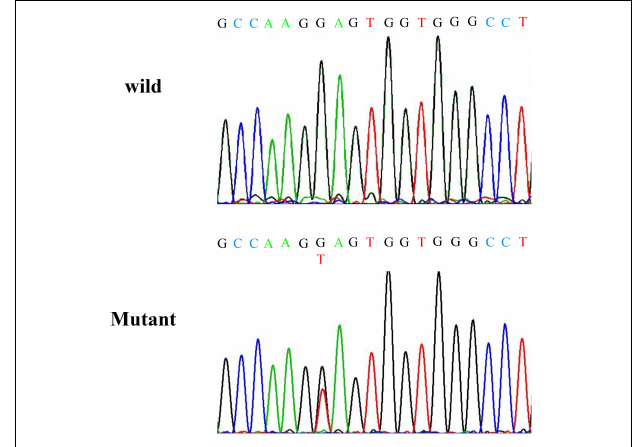
FIGURE 1 | Results of Sanger sequencing. Sanger sequencing indicates a nonsense mutation at codon position 562 of exon 13 of